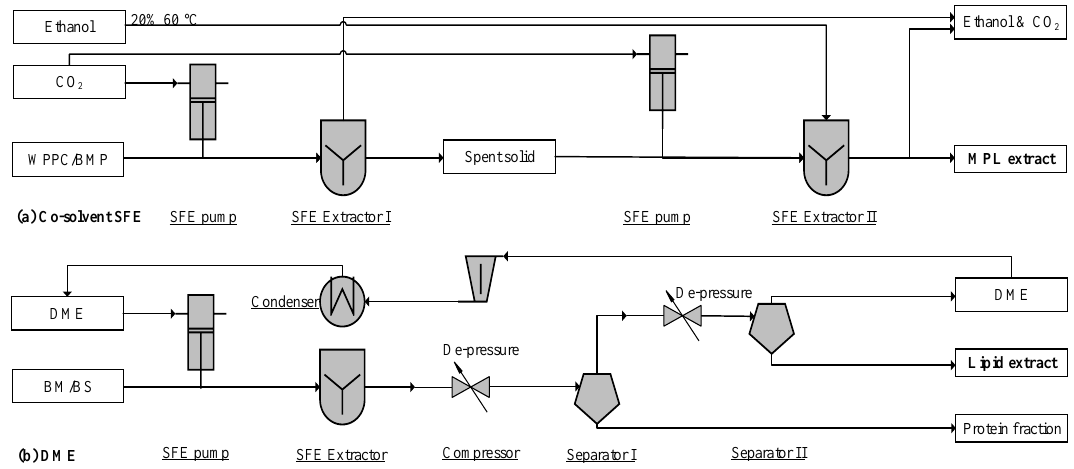
Figure 3. Process flow diagram of a supercritical fluid extraction (SFE) unit: ( a ) adapted from Li [49] and ( b ) Kala et al. [97]; WPPC, whey protein phospholipid concentrate; BS, beta serum; BM, buttermilk; BMP, buttermilk powder; DME, dimethyl ether.